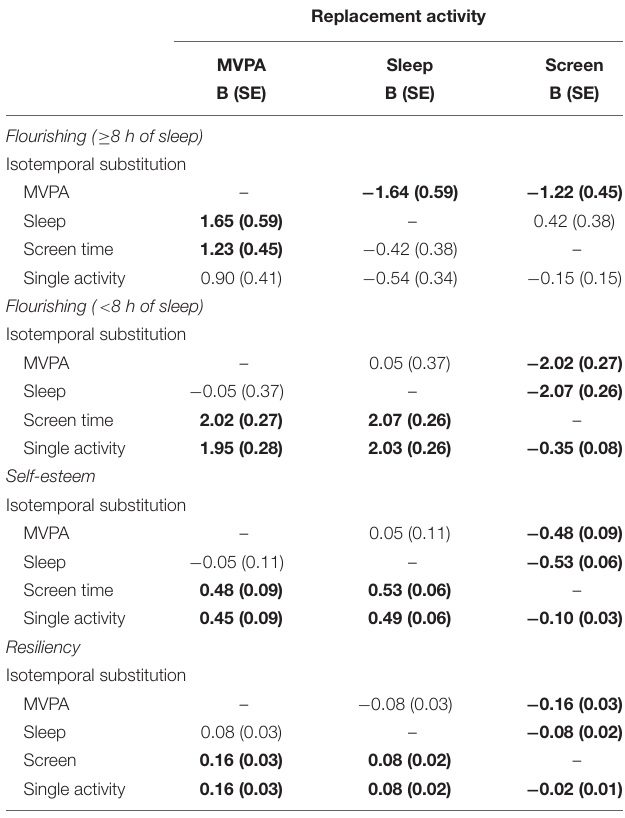
TABLE 2 | Single and isotemporal substitution models predicting indicators of mental